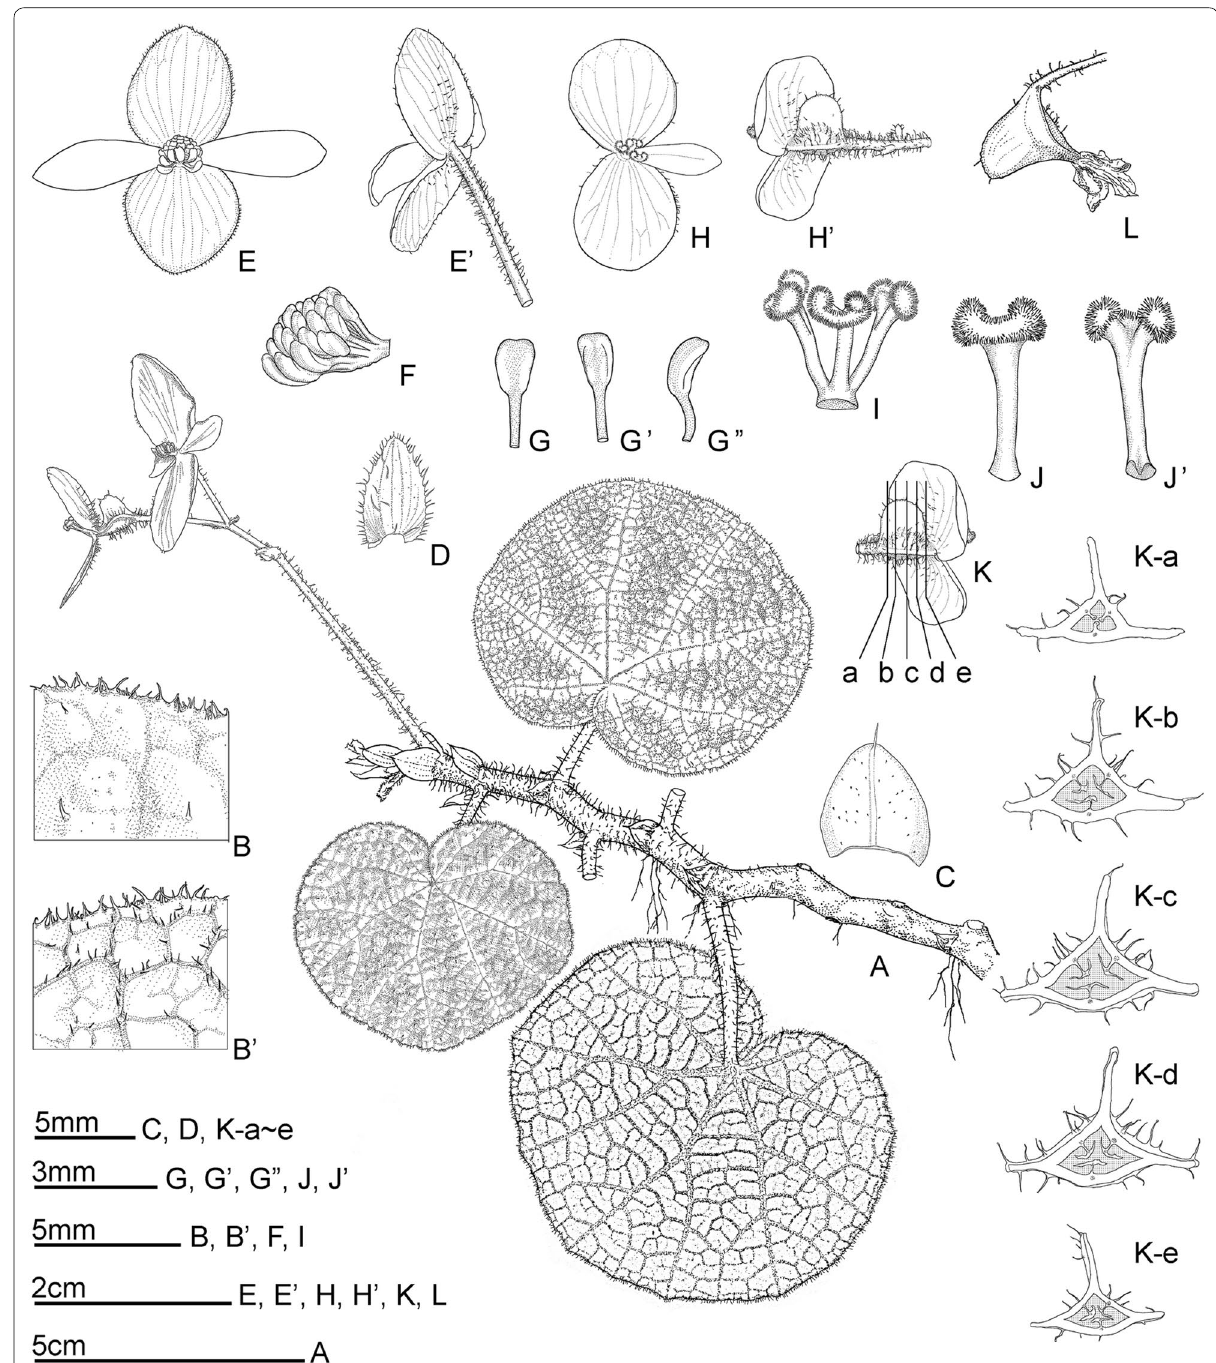
Fig. 14 Begonia zhuoyuniae C.I Peng, Yan Liu & K.F.Chung. A Habit; B , B’ Portion of leaf, showing indumentum on adaxial and abaxial surfaces; C Stipule; D Bract; E , E’ Staminate flower, face and back views; F Androecium, side view; G , G’ , G” Stamens; H , H’ Pistillate flower, face and back views; I , J , J’ Style and Stigmas; K-A – K-E Serial cross sections of ovary; L Fruit. All from Peng et al . 20737 ‑